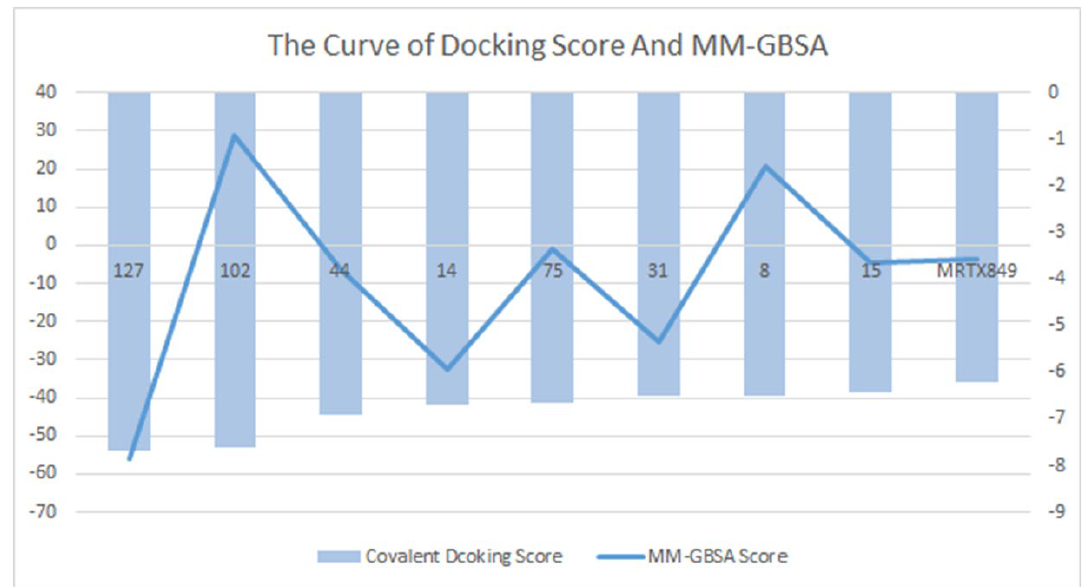
Figure 6. Compounds that were identified as active by random forest classifiers and were superior to positive controls in covalent screening with KRAS G12C protein docking results and MM-GBSA results.